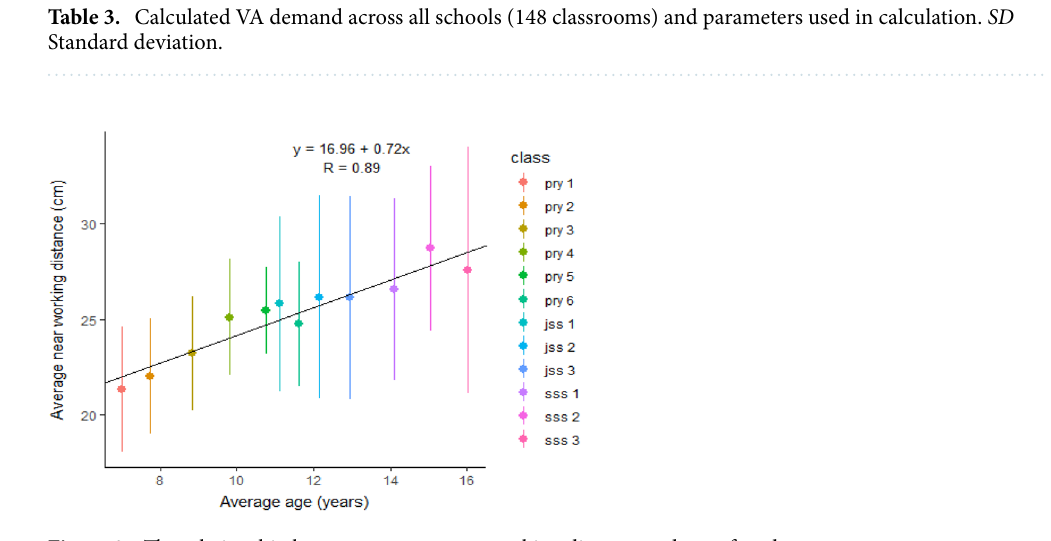
Figure 2. The relationship between average near working distance and age of